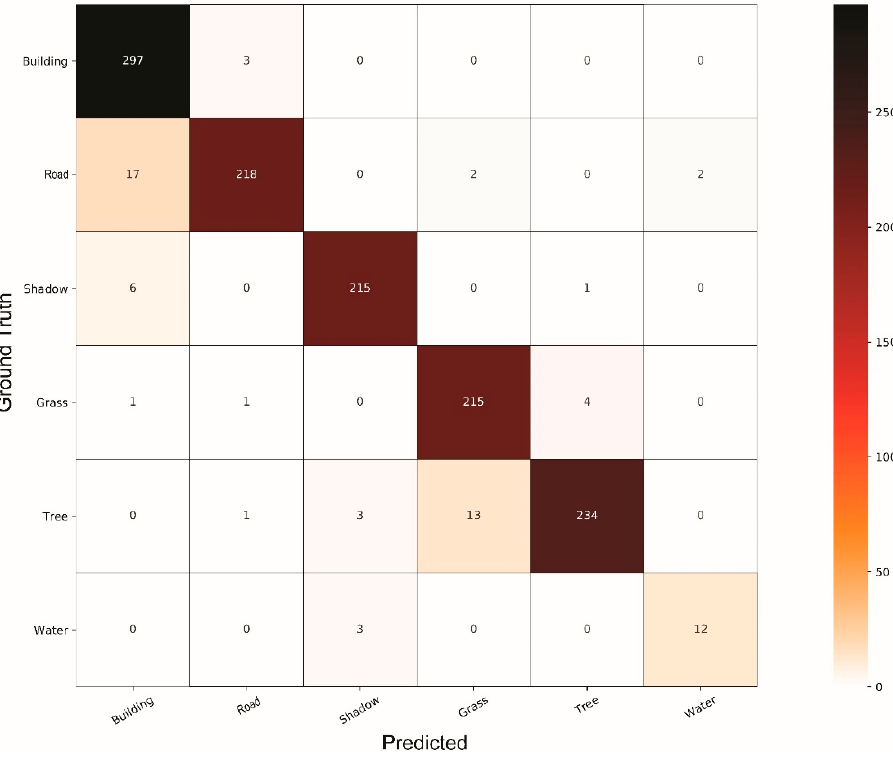
Figure A6. Confusion matrix of the SVM for 30 cm image.